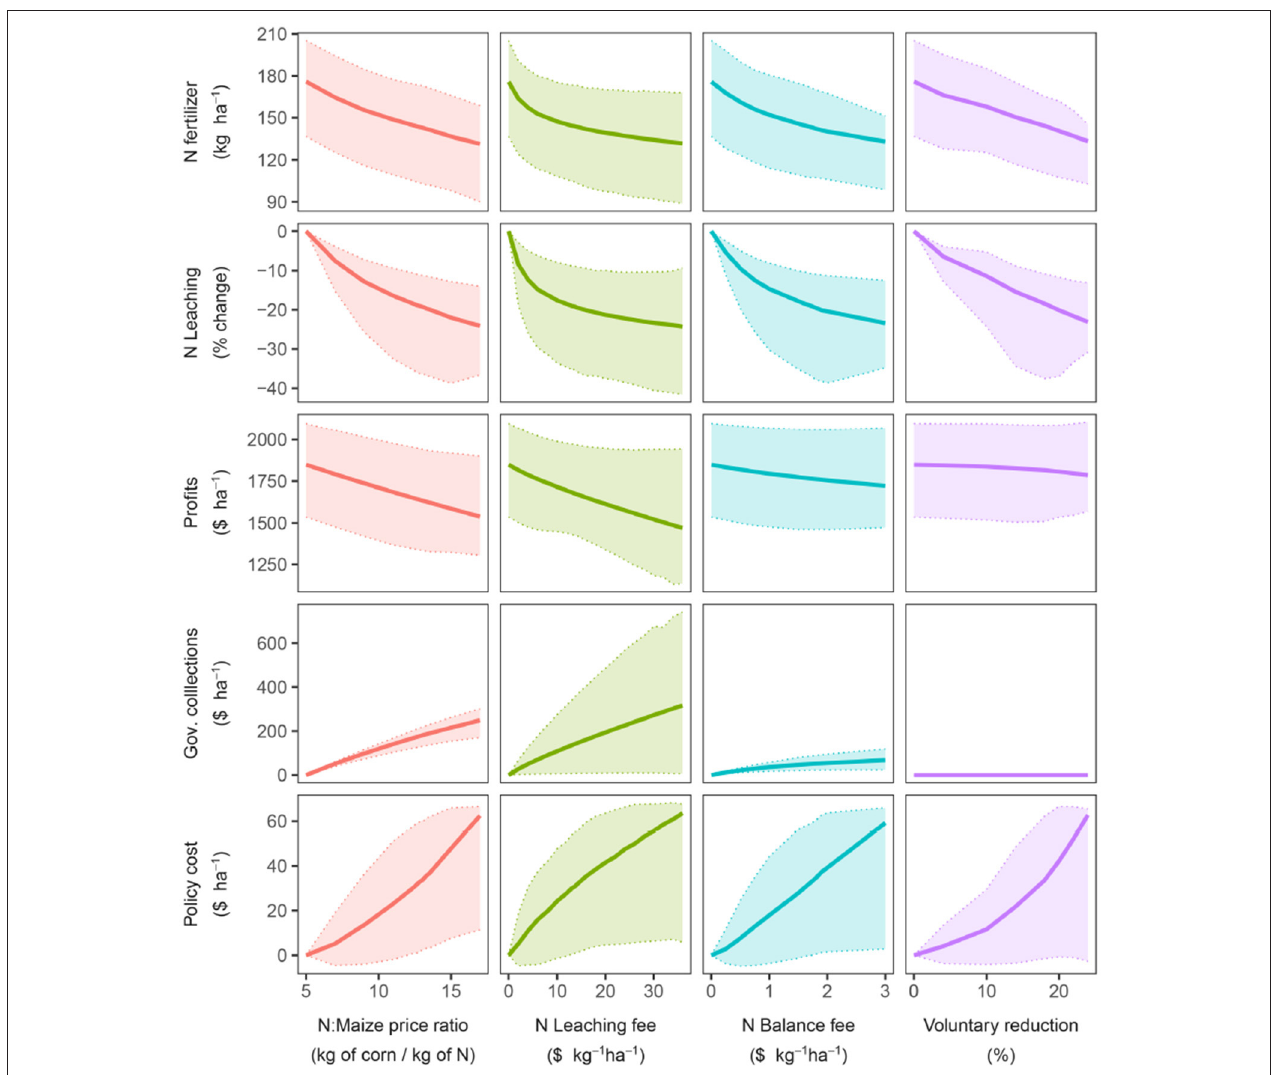
FIGURE 2 | Trajectory of N fertilizer use, N leaching, Farm profits, government collections, and policy cost for the four policies. Solid line shows the mean. The shaded area indicates the 10 and 90% quantiles across fields (averaged across